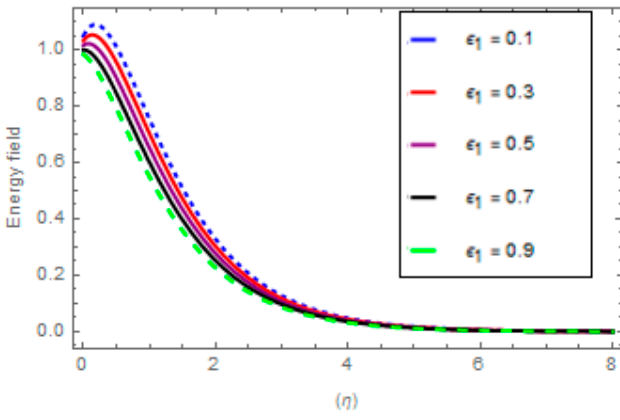
( ) ϕ η ( ) ϕ η ( ) ϕ η ∈ ∈ ∈ via . via . 1 via .